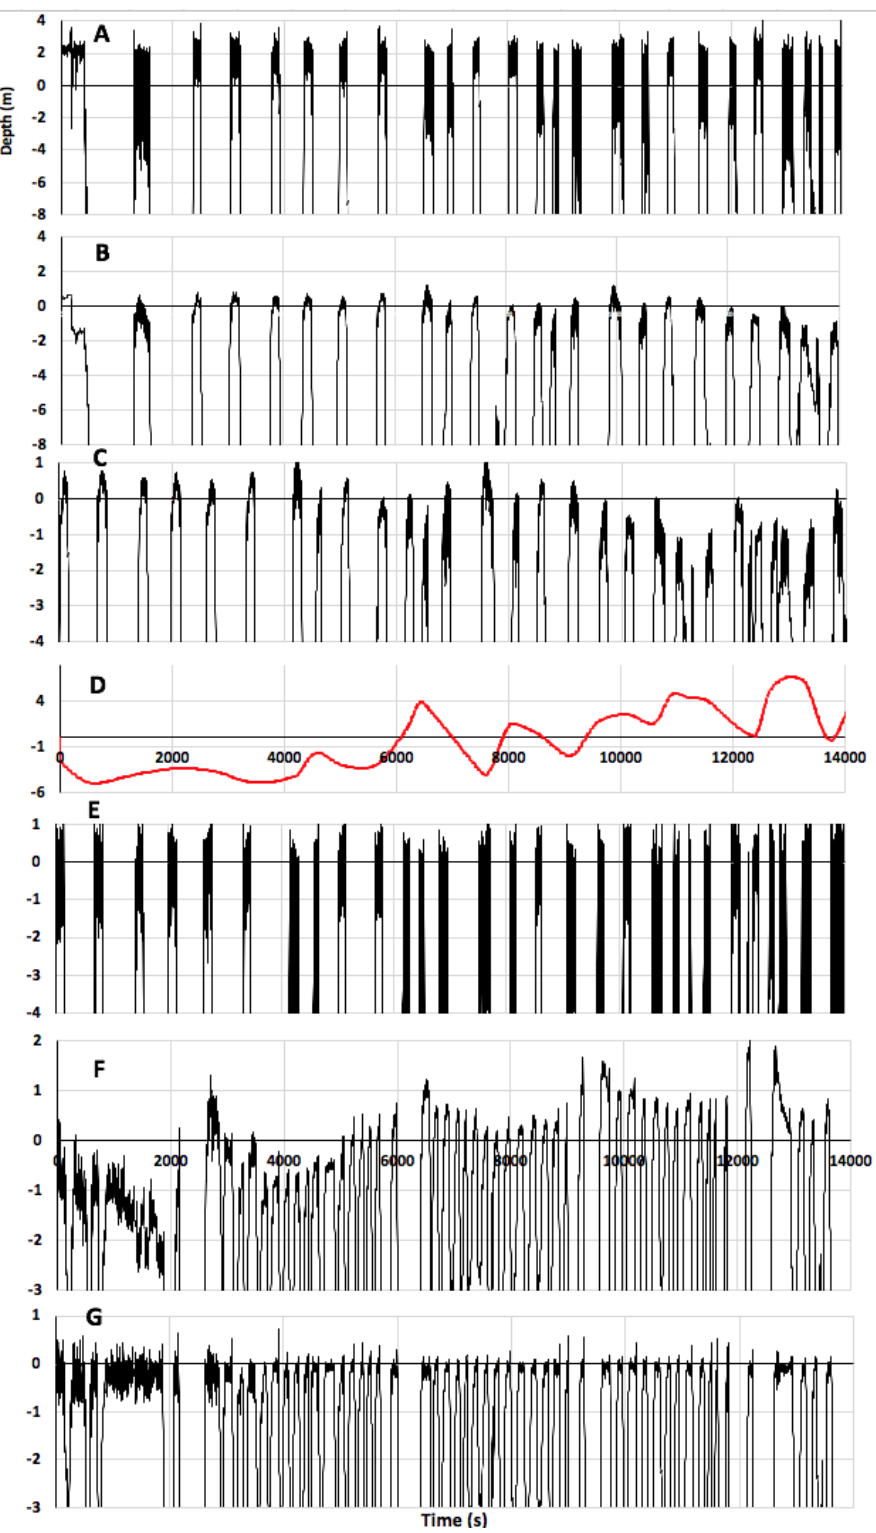
Figure 3: Examples of baseline corrections of the surface (0 m) from Acousonde TM Balder August 2016. A: Uncorrected and corrected baseline (B), C: Uncorrected baseline with overshoot template (D) and zero offset corrected (E). Sample of example of an uncorrected (F) and a zero offset corrected dive series